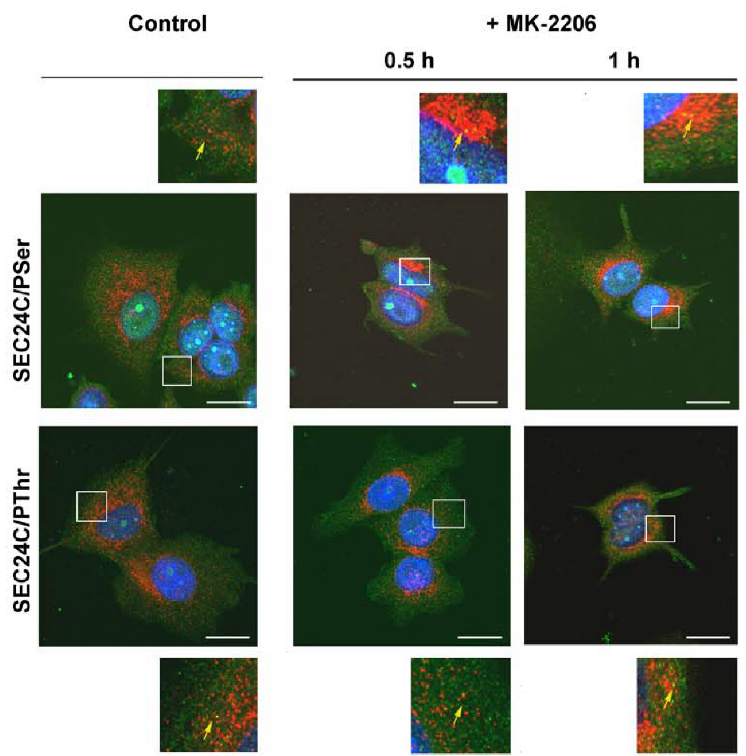
Figure 7. Immunocytochemistry analysis of SEC24C phosphorylation in MCF-7 cells. Untreated cells or cells incubated for the indicated time with 5 µ M MK-2206 were fixed and subjected to the immunocytochemistry procedure, as described in Section 2.4. The following primary antibodies were used: rabbit anti-SEC24C (1:250, red) with either mouse anti-phosphoserine (1:250, green) or mouse anti-phosphothreonine (1:200, green), as indicated on the left. The selected areas are shown as magnified images either above or below the corresponding panels. The detected co-localizations of SEC24C and phosphorylated amino acid are indicated with yellow arrows. Representative images from 2 independent cell passages subcultured in 3 different coverslips each are shown. The selected images come from the same passage. Bar: 20 µm.